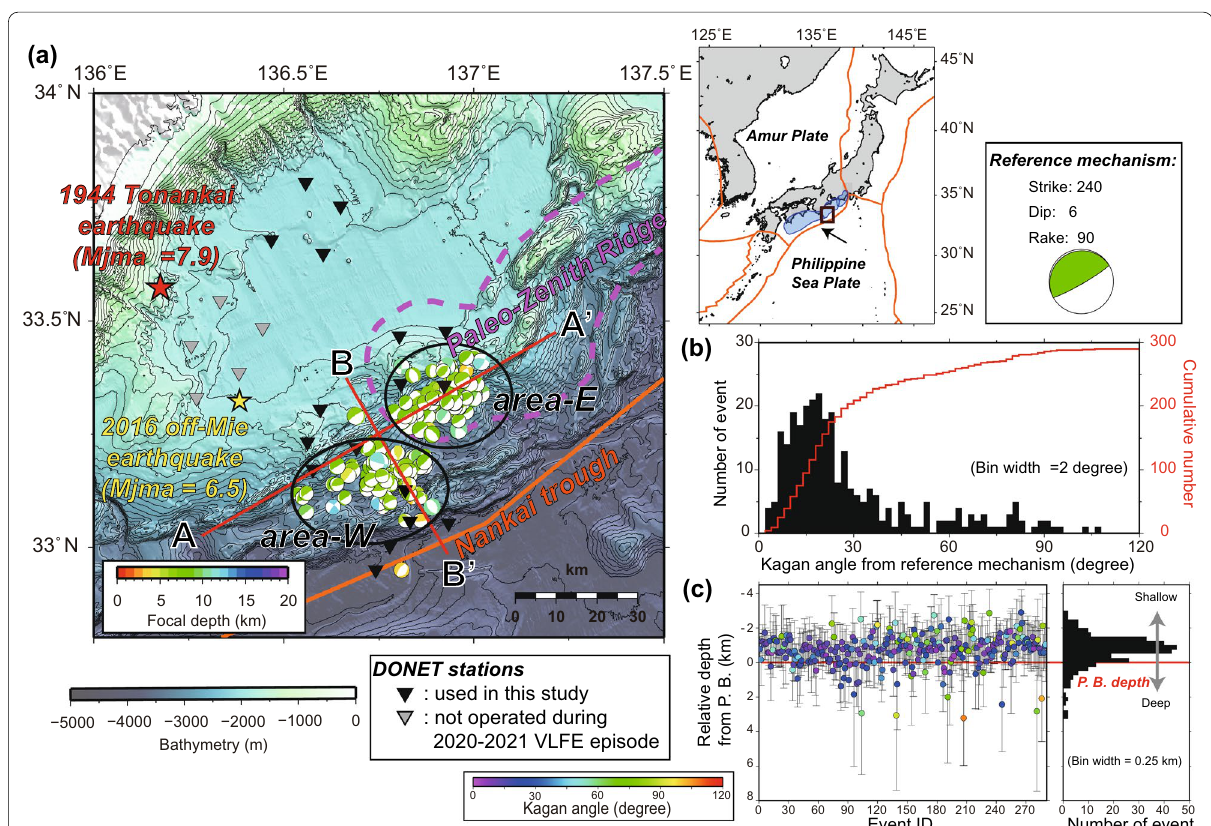
Fig. 1 Study area and observed shallow very-low-frequency earthquake (sVLFE) distribution. a Distribution of the centroid moment tensor (CMT) solutions of the sVLFEs and the Dense Oceanfloor Network System for Earthquakes and Tsunamis (DONET) stations on a bathymetry map. The color of the CMT solutions indicates the focal depth. The area outlined by the pink dashed line indicates the location where the paleo-Zenith Ridge subducted (Park et al. 2004). The epicenters of the 1944 Tonankai and 2016 off-Mie earthquakes are indicated by red and yellow stars, respectively. The right-top panel shows the regional map and the surrounding plate boundaries (Bird 2003). The dark brown rectangle indicates the area shown in a . Blue-masked areas correspond to the assumed areas of the Tokai, Tonankai, and Nankai seismogenic zones. The arrow shows the relative motion vector of the Philippine Sea Plate to the Amur Plate (Argus et al. 2011). b Distribution of the Kagan angle of the CMT solutions with respect to the reference mechanism assuming a pure thrust fault along the plate boundary. c Relationship between the average focal depth estimated using the bootstrap method and the plate boundary model (Nakanishi et al. 2018). The color and the vertical bar in the left panel indicate the Kagan angle with the reference mechanism and the standard deviation of the depth estimation,